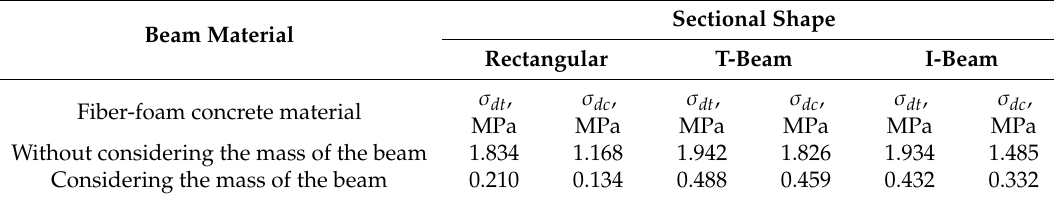
Table 5. Maximumdynamicstressesarisinginbeamsofrectangular,T-andI-shape,consideringbimodularity.